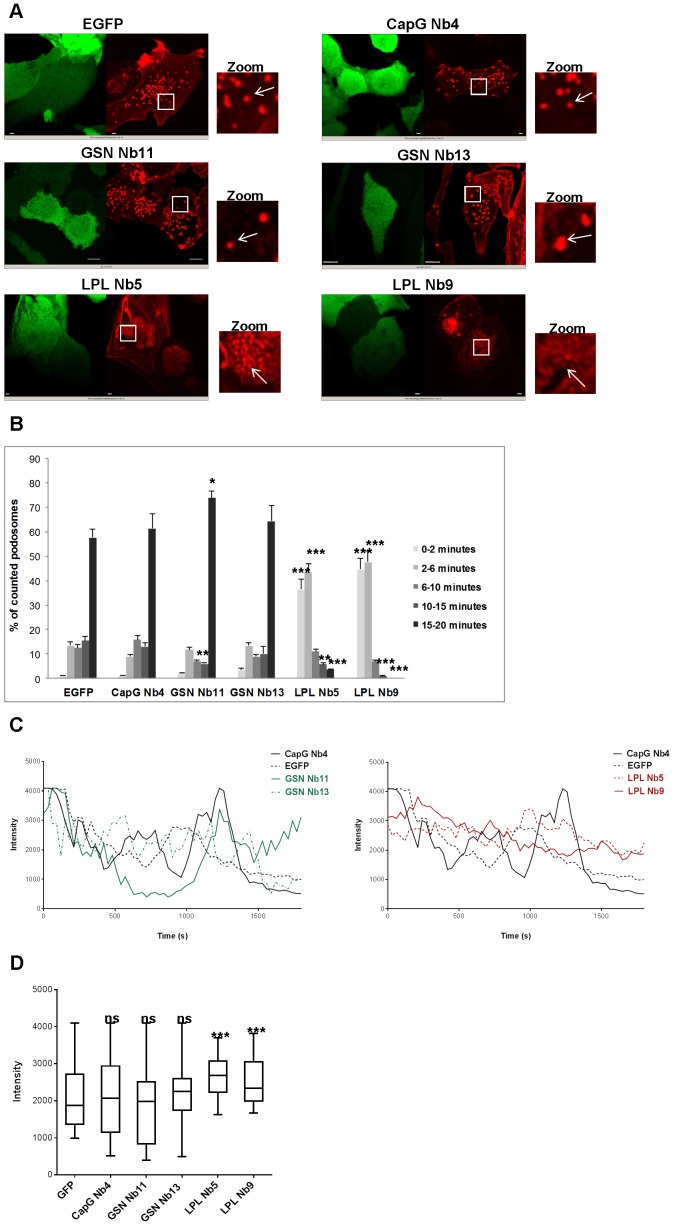
Podosomes from LPL Nb-expressing cells are dynamically unstable.(A) Stable THP-1 cells constitutively expressing the F-actin binding peptide LifeAct-mCherry and EGFP-tagged LPL Nb5/9, GSN Nb11/13, CapG Nb4 or EGFP were differentiated into macrophages by addition of PMA for 3 days. A 2D reconstruction of podosome turnover in the cells was acquired by time-lapse confocal imaging of life cells for 20 minutes. Actin is shown in red and stable cells in green. The arrow marks the podosome of which the relative actin intensity profile, described in C and D, was determined. Bar: 10 µm. (B) Representation of the average lifetime of podosomes for the different constructs. The lifetime of 120–150 podosomes in 8–12 cells was determined per condition in 3 independent experiments. Error bars represent mean ± SEM. Unpaired t-tests were performed to observe statistical differences between cells expressing EGFP and cells expressing the nanobodies. Statistically significant differences are denoted. (C) Representation of the relative actin intensity profile of a podosome as a function of time for CapG Nb4 (solid line, black), EGFP (dashed line, black), GSN Nb11 (solid line, green), GSN Nb13 (dashed line, green), LPL Nb5 (dashed line, red) and LPL Nb9 (solid line, red). Relative actin intensity profiles were generated for 10–15 podosomes in 5–10 cells per condition. The chosen examples are representative of the generated profiles. (D) Boxplot of the actin intensities (shown in C) for the different constructs. Mann-Whitney Rank Sum tests were performed to observe statistical differences in the distribution of the intensities between cells expressing EGFP and cells expressing nanobodies (ns: non significant p>0.05; * p<0.05; ** p<0.01; *** p<0.001).